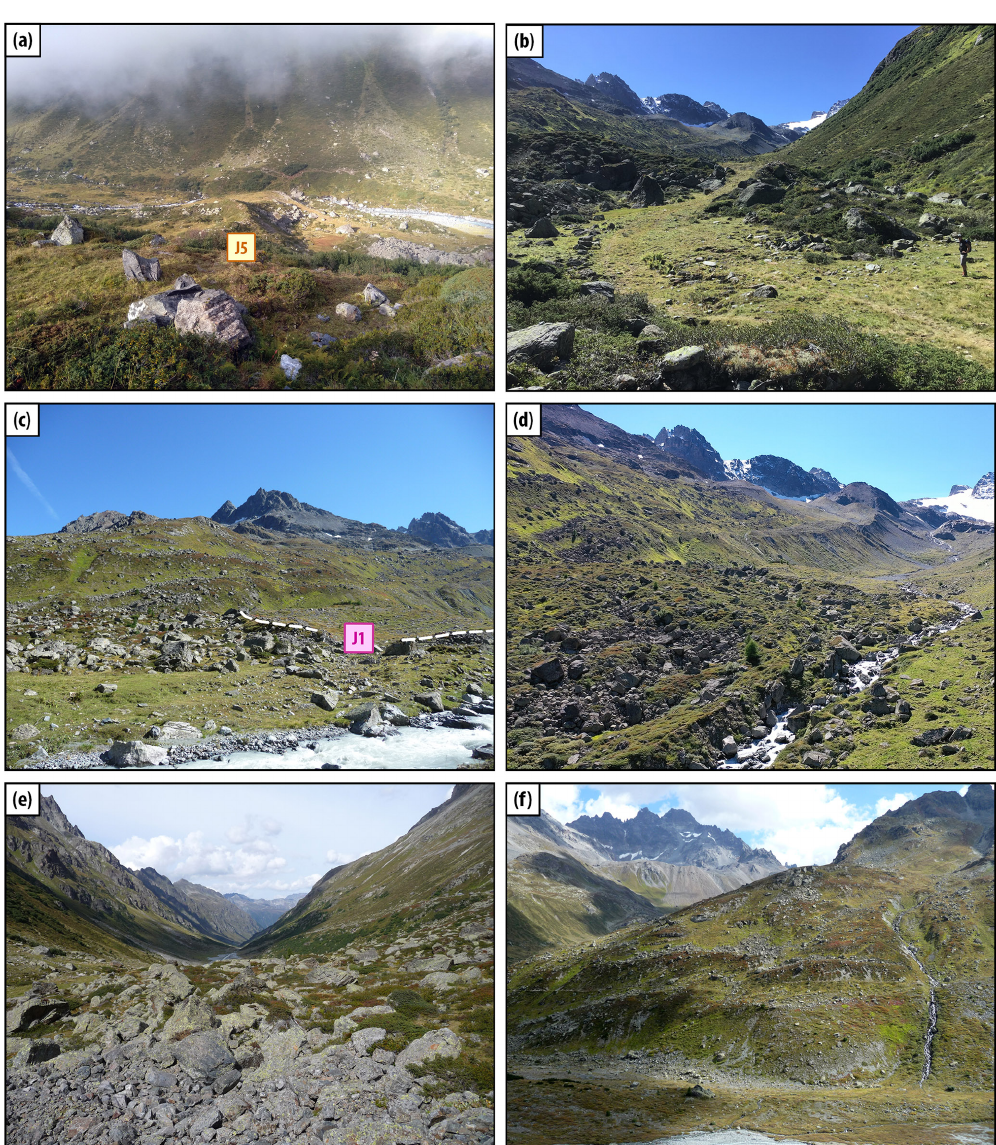
Figure A2. Jamtal. (a) J5 ridge view from right-lateral valley side towards the west and a (b) view from a down-valley position southwards. The structure was reworked in the course of trail construction and maintenance. (c) Transition zone between J1 terminal moraine and the blockfield. We speculate that the blockfield originates from rock failures along valley flanks farther up valley. Corresponding debris was transported downstream by the glacier. During glacier retreat, the blocks melted out and covered the valley floor. The blockfield (at least its uppermost section) was then partly overprinted by subsequent glacier advances. (d) Blockfield consisting of coarse, angular to subangular components with a view towards the southeast. (e) Transition zone between fresh J1 moraine deposits and the blockfield, whose blocks are populated by lichens and are partly overgrown with vegetation. (f) Displaced moraines along the right-lateral valley side outboard J1; Futschöltal (tributary valley) is shown in the